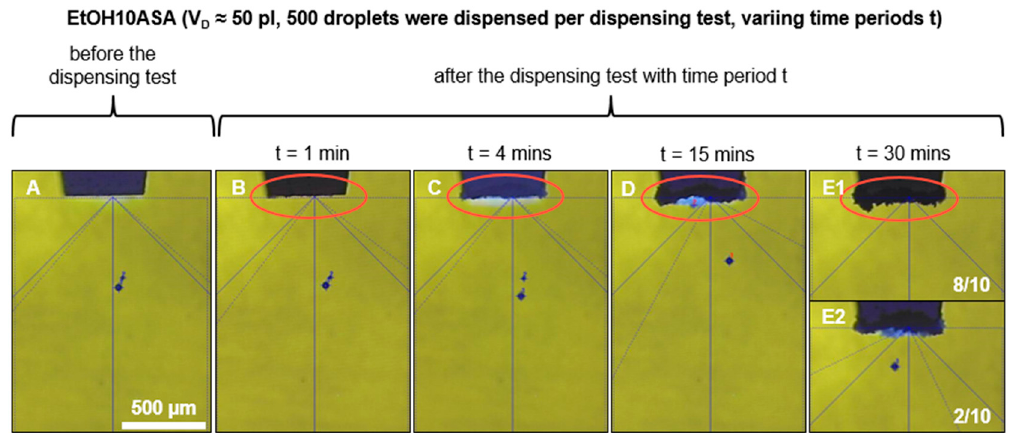
Figure 6. Droplet formation before ( A ) and the end of the dispensing tests with different time periods ( B – E ). 500 droplets of the drug solution EtOH10ASA were ejected uniformly over each of the four different time periods. Drug deposition increases with increasing time period (circled red). Clogging of the nozzle and cessation of droplet formation were detected only for the time period t = 30 min at eight out of ten experimental replicates ( E1 ). Droplet formation still occurred in 2 out of 10 experimental replicates but was significantly impaired ( E2 ).